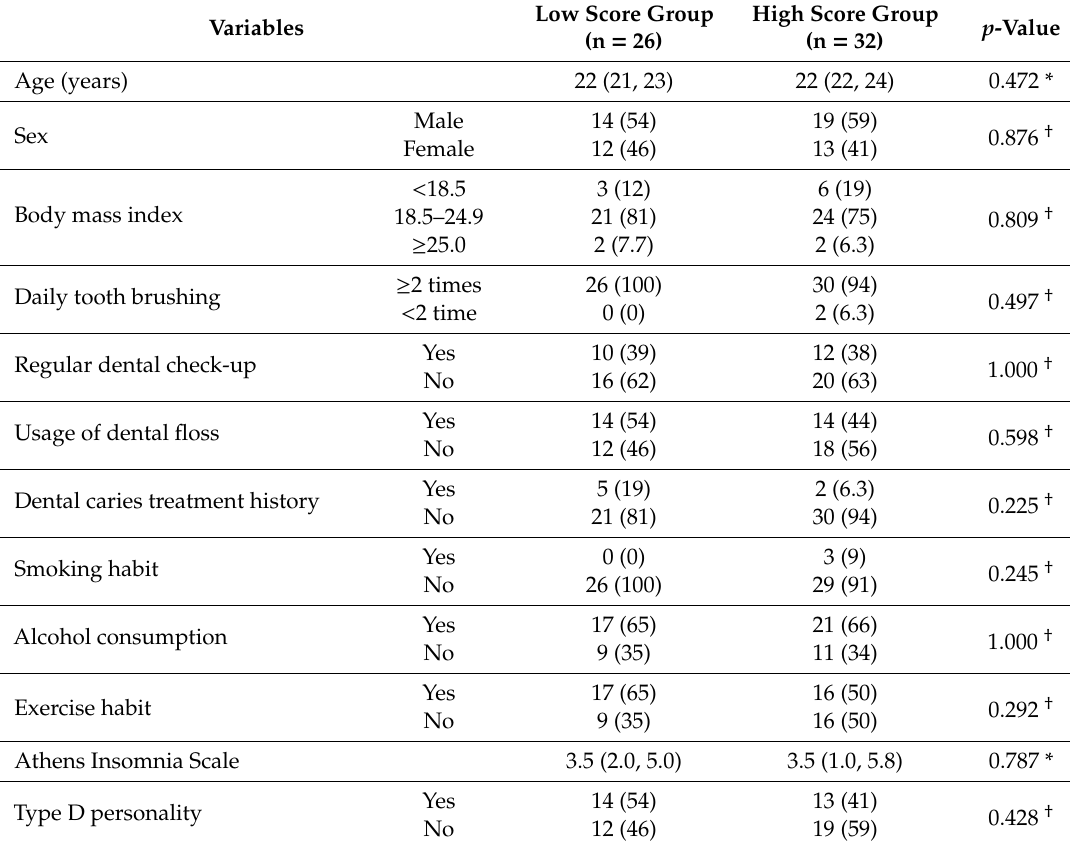
Table 2. Comparison of variables in the two groups based on the GOHAI